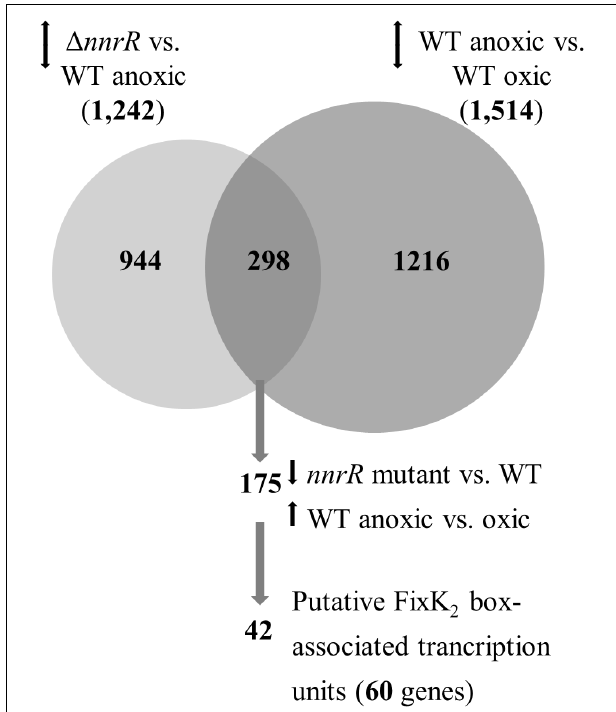
FIGURE 1 | Venn diagram representing the group of differentially expressed genes in the nnrR mutant in comparison to the WT, both grown in anoxic denitrifying conditions (light gray circle), and the group of differentially expressed genes in cells of the WT grown in anoxic denitrifying conditions compared with cells grown in oxic conditions (dark gray circle). Numbers in parentheses indicate the total number of differentially expressed genes. The overlap of both groups represents 298 genes; among them, 175 genes showed a downregulated expression in the nnrR mutant and at the same time are induced in the WT grown in anoxic denitrifying conditions. The latter set contains 60 genes organized in mono-, or polycistronic transcriptional units that contain a putative FixK 2 box in the promoter region (42 FixK 2 boxes associated to transcriptional units, see Table 1 ). Up-down arrows refer to increased and decreased gene expression in microarray